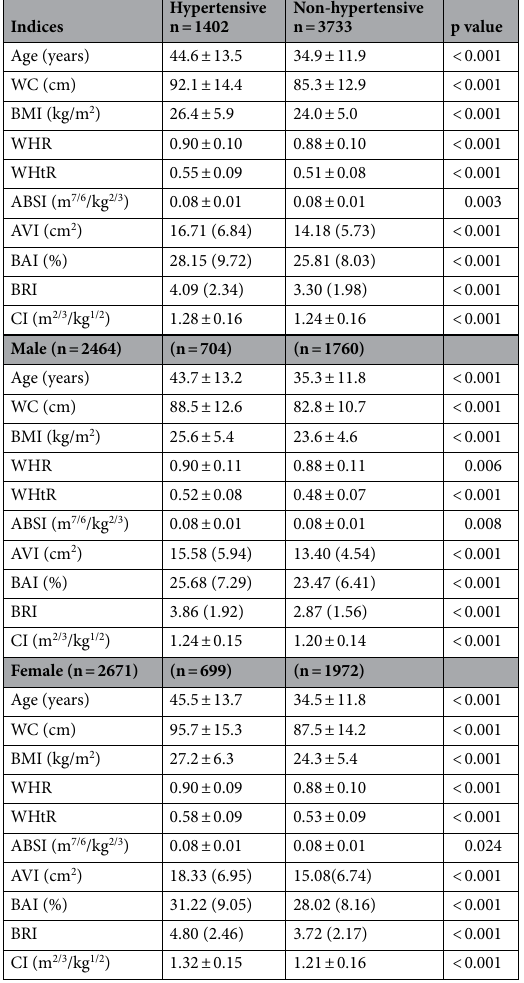
Table 2. Comparison of anthropometric indices in hypertensive and non-hypertensive population stratified by gender. Data presented as mean ± standard deviation or median (interquartile range). The full data points for ABSI in Hypertensive/Non-hypertensives are, 0.08013 ± 0.0103/0.07915 ± 0.0105, 0.07806 ± 0.01000/0.076919 ± 0.00965 and 0.08221 ± 0.01037/0.08114 ± 0.010847 for total, male and